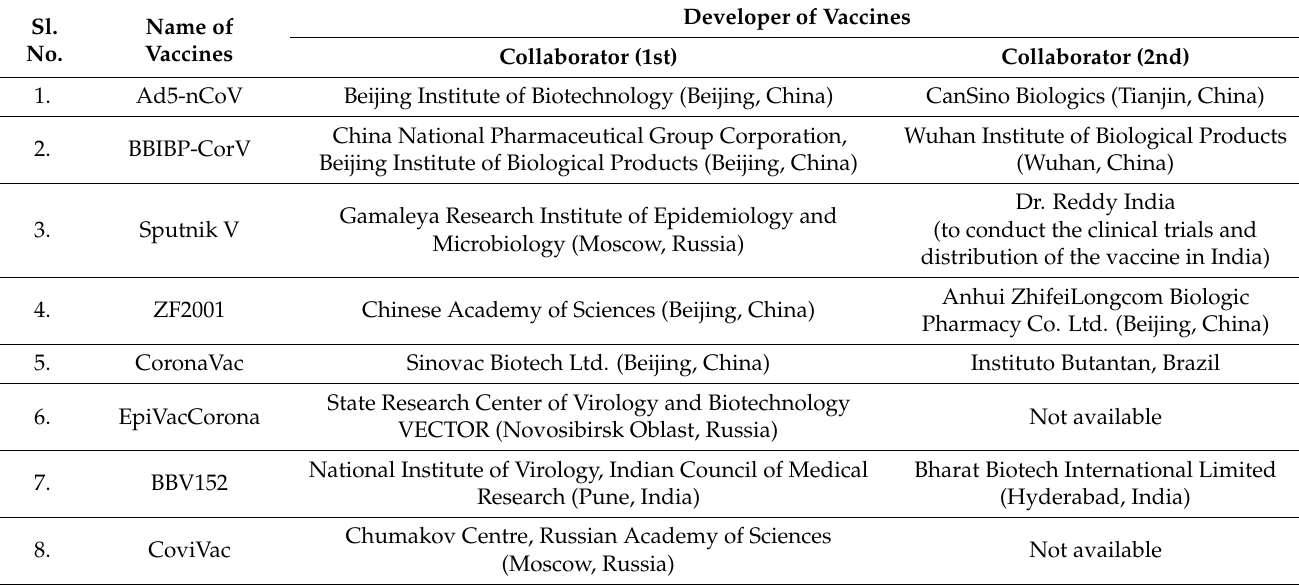
Table 2. Different stages of collaboration between the collaborators involved in the development of COVID-19 vaccines. This table provides information about the COVID-19 vaccines from Asia and approved by at least one country. Sl.